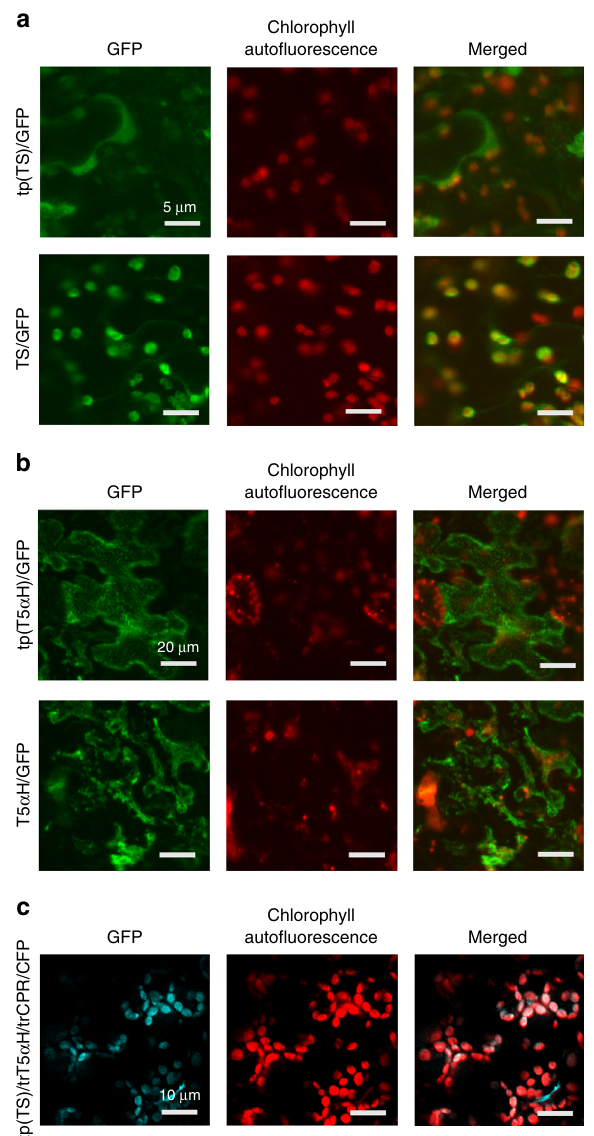
Fig. 3 Intracellular organelle localization and targeting of heterologous proteins. Fluorescence labeling of the fusion proteins; a tp(TS)/GFP, TS/ GFP; b tp(T5 α H)/GFP, T5 α H/GFP, and c tp(TS)/trT5 α H/trCPR/CFP. Agrobacterium containing individual plasmids were introduced into the leaf lower epidermis of N. benthamiana . Leaf discs were harvested 3 days post in fi ltration and epidermal strips were observed by a confocal